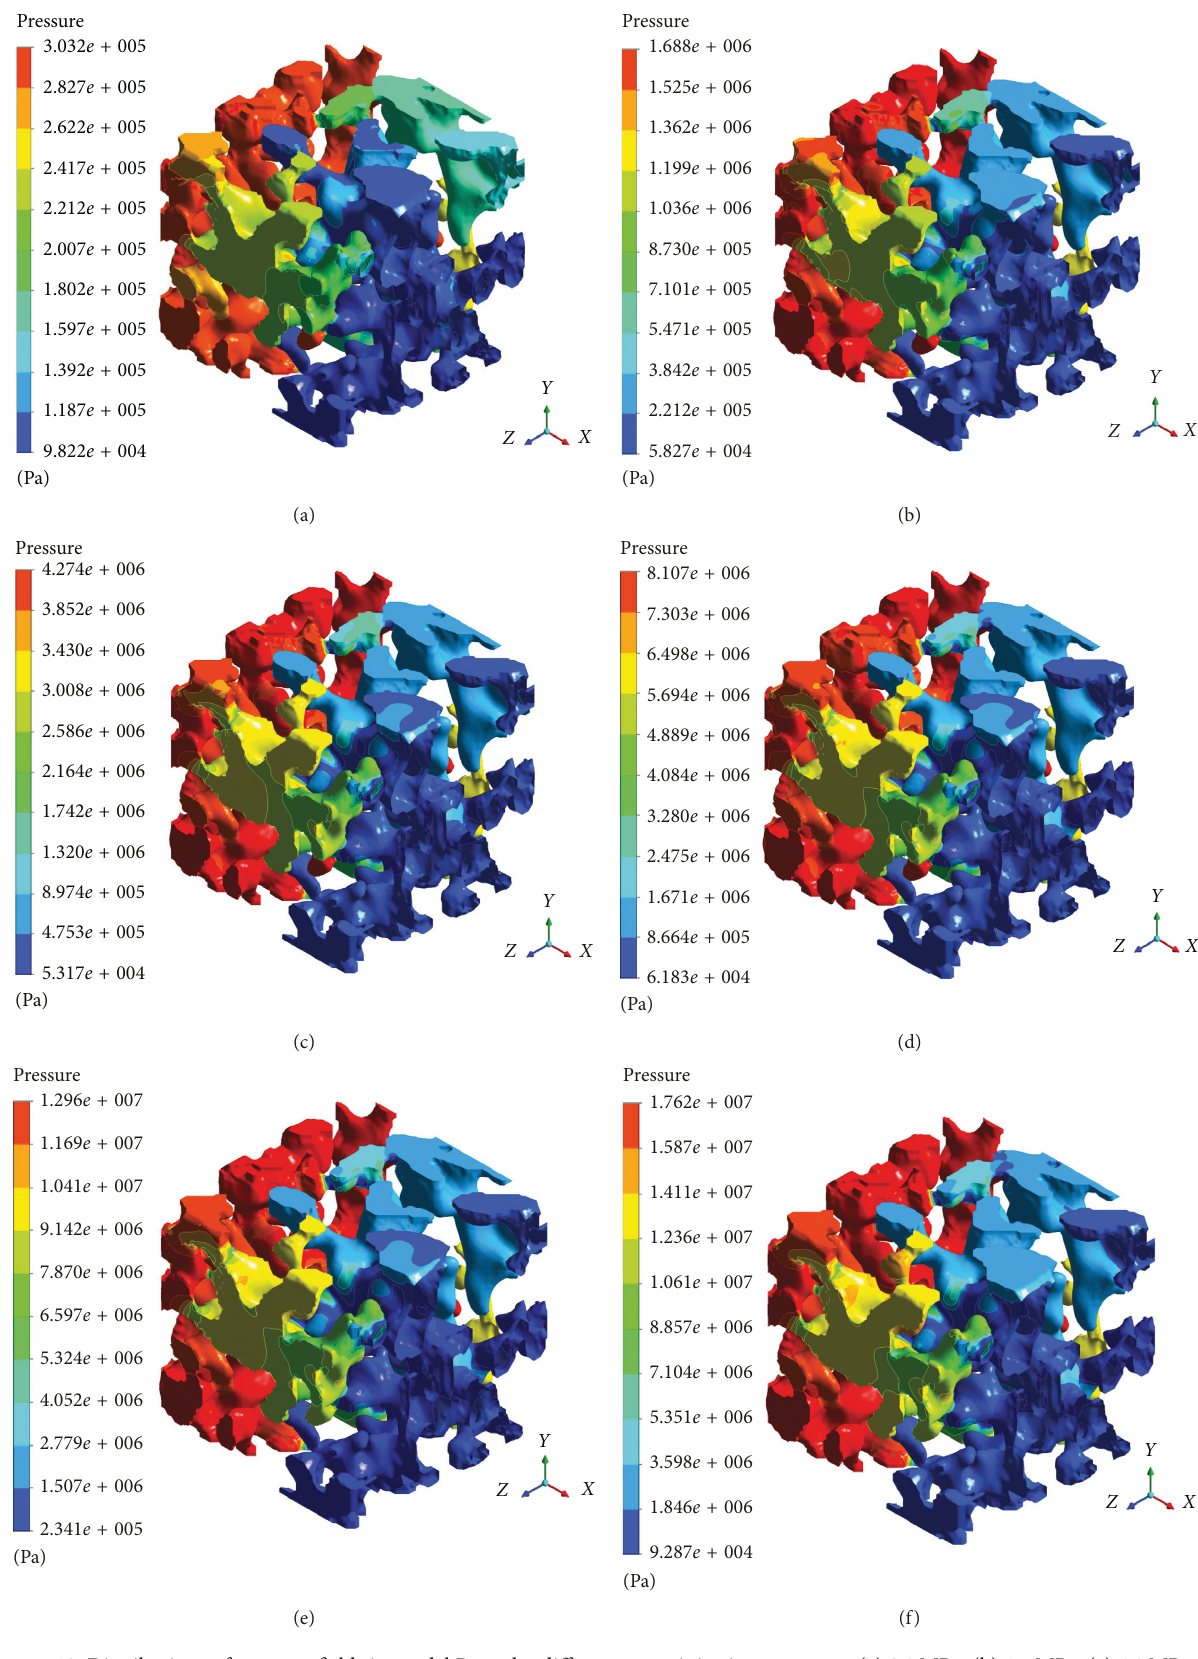
Figure 13: Distributions of pressure fields in model P 1 under different water injection pressures. (a) 0.3MPa. (b) 1.7 MPa. (c) 4.3MPa. (d) 8.1MPa. (e) 13.1MPa. (f)